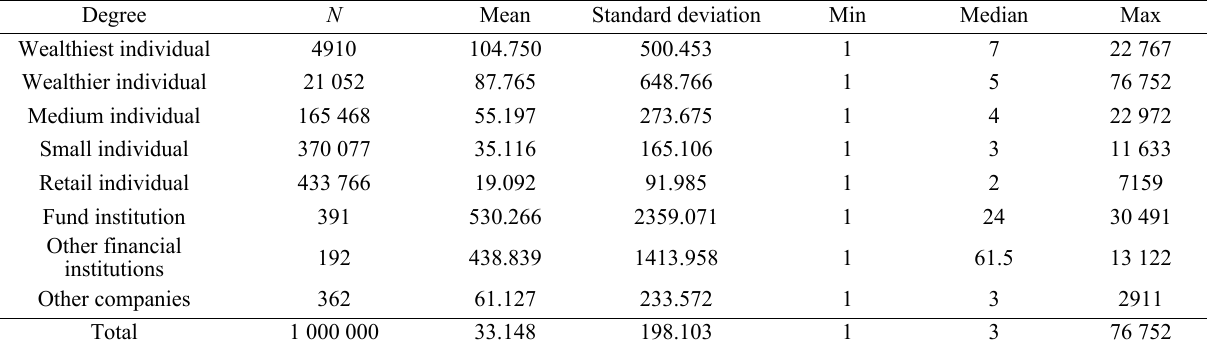
Table 8 Descriptive statistics of the number of connections of investors’ social network.